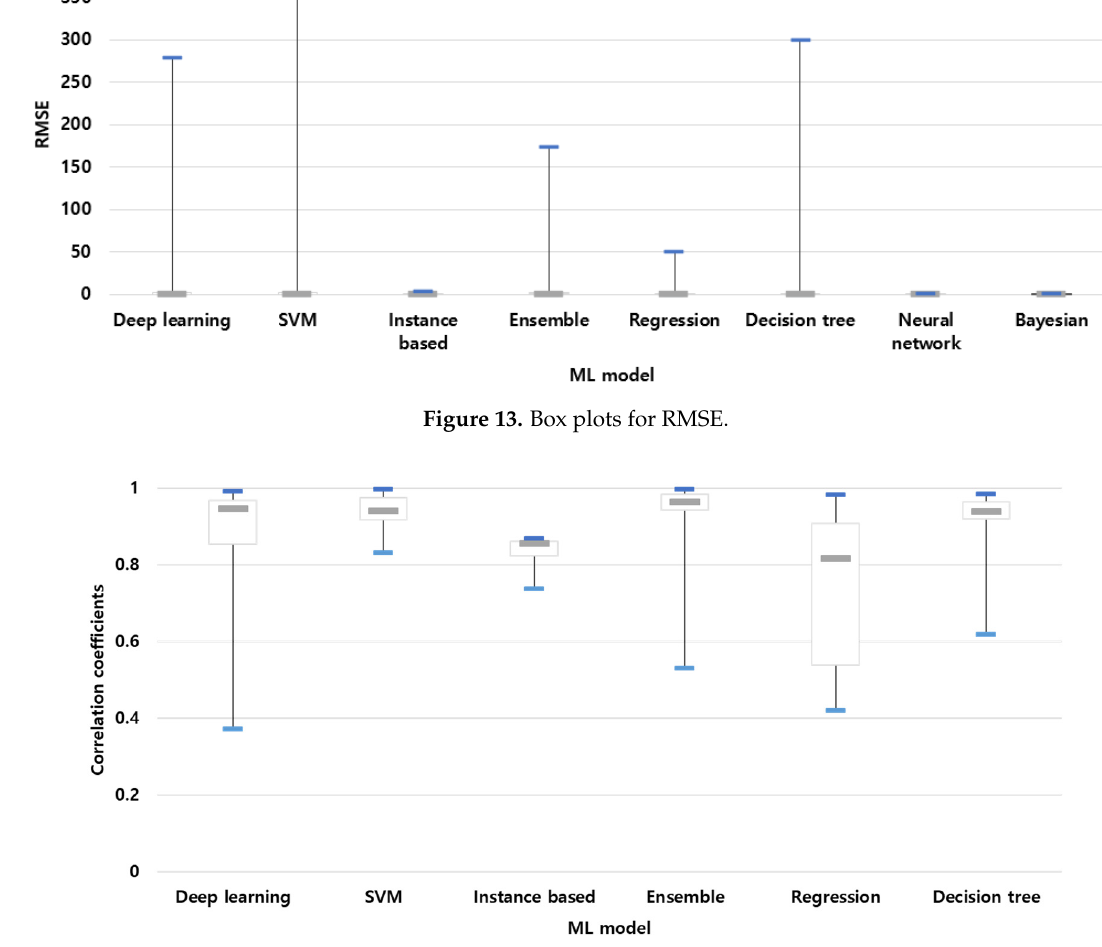
Figure 15. Box plots for accuracy.